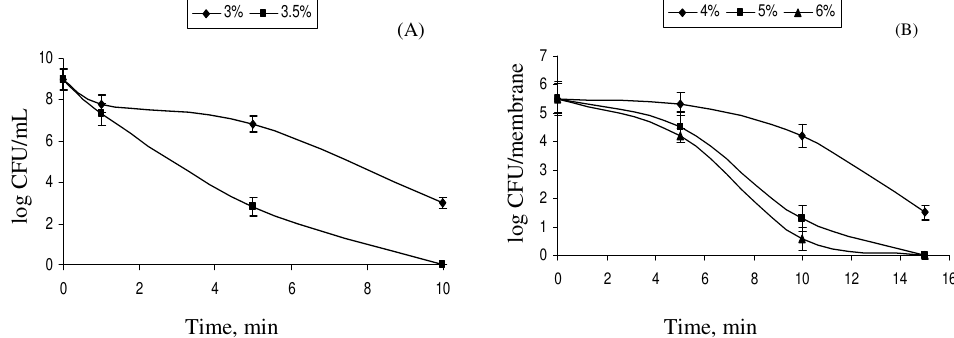
Figure 3 . Effect of different concentrations of H cells of L. monocytogenes at 30 °C. The initial concentration of cells in planktonic and biofilm was 2.57 x 10 9